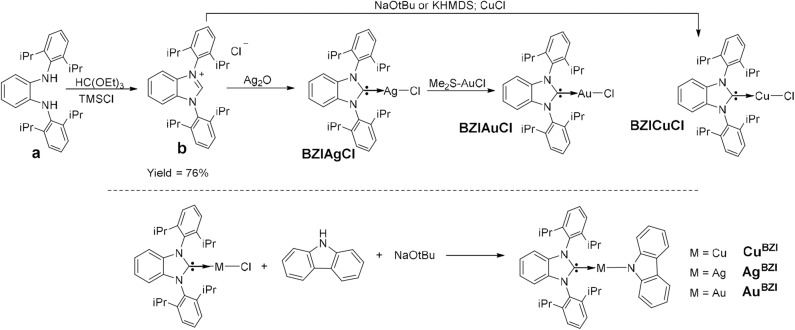
Synthetic route used in the preparation of two-coordinate coinage metal complexes MBZI.